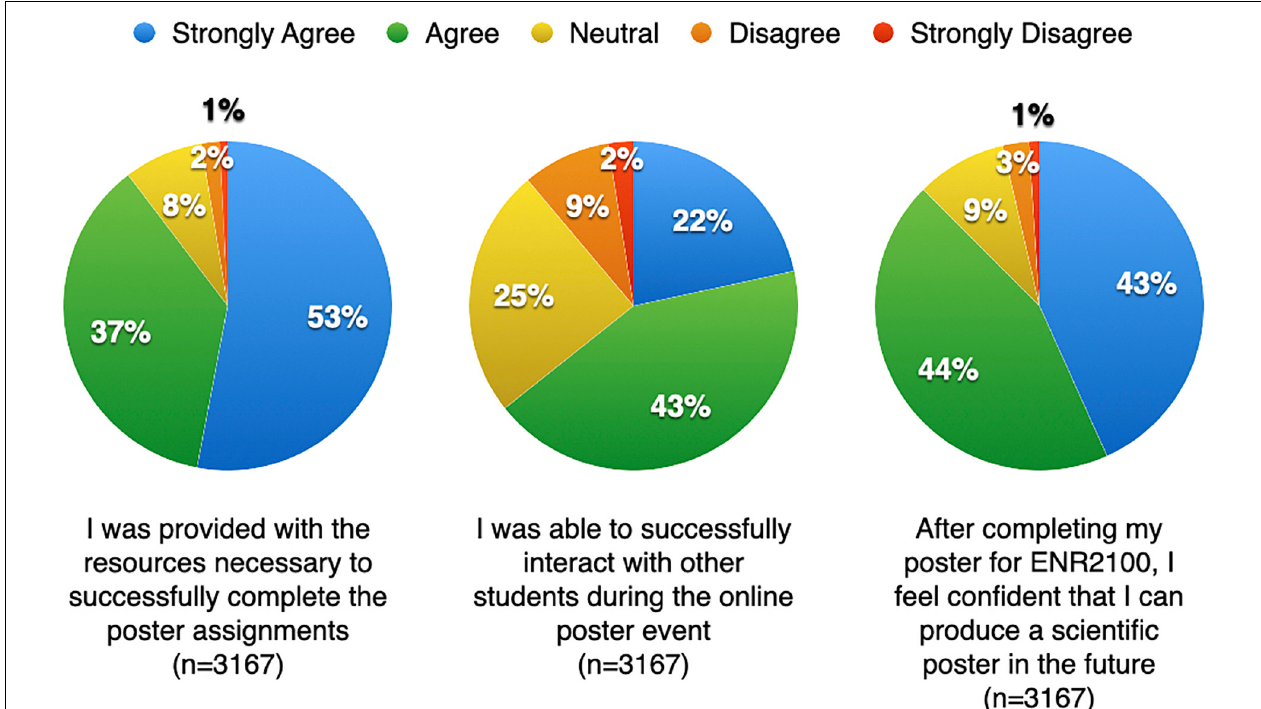
FIGURE 2 | Timeline of poster assignments. Students completed a total of 6 poster assignments during a 15-week semester. PA1 and PA2 were a short-answer quizzes. Students submitted a poster PDF file for PA3 and PA4. Students submitted a poster PDF file and 5-min audio (or video) presentation for PA5. For PA6, each students completed 2 poster peer reviews during the online poster symposium. The online poster symposium was open for 6 days during Week 14 of the semester. All poster assignments were open book. Students were given 7–21 days to complete each poster assignment. Students completed and submitted all poster assignments using Canvas Learning (https://carmen.osu.edu). Poster files submitted for PA3, PA4, and PA5 were uploaded to Canvas and automatically screened for original content by Turnitin software (https://turnitin.com). Each poster assignment was graded using a rubric and feedback was provided to each student through Canvas. The point value for each poster assignment is provided at the bottom. PA, Poster